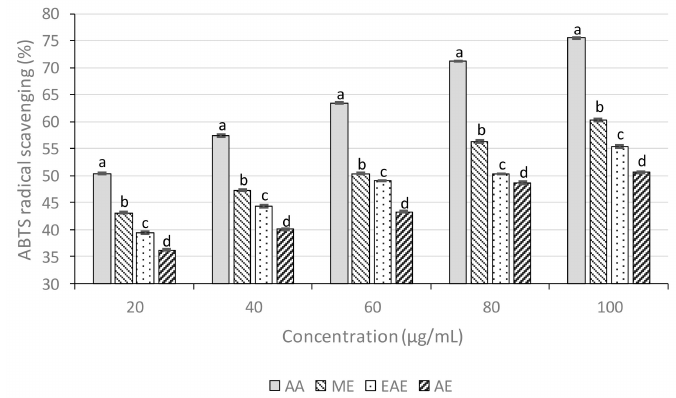
Figure 2. ABTS[2,2”-azino-bis(3-ethylbenzothiazoline-6-sulphonic) acid] radical scavenging activity of leaves extracts. Statistical significance was determined at p < 0.05 and is indicated with di ff erent letters (each concentration was evaluated